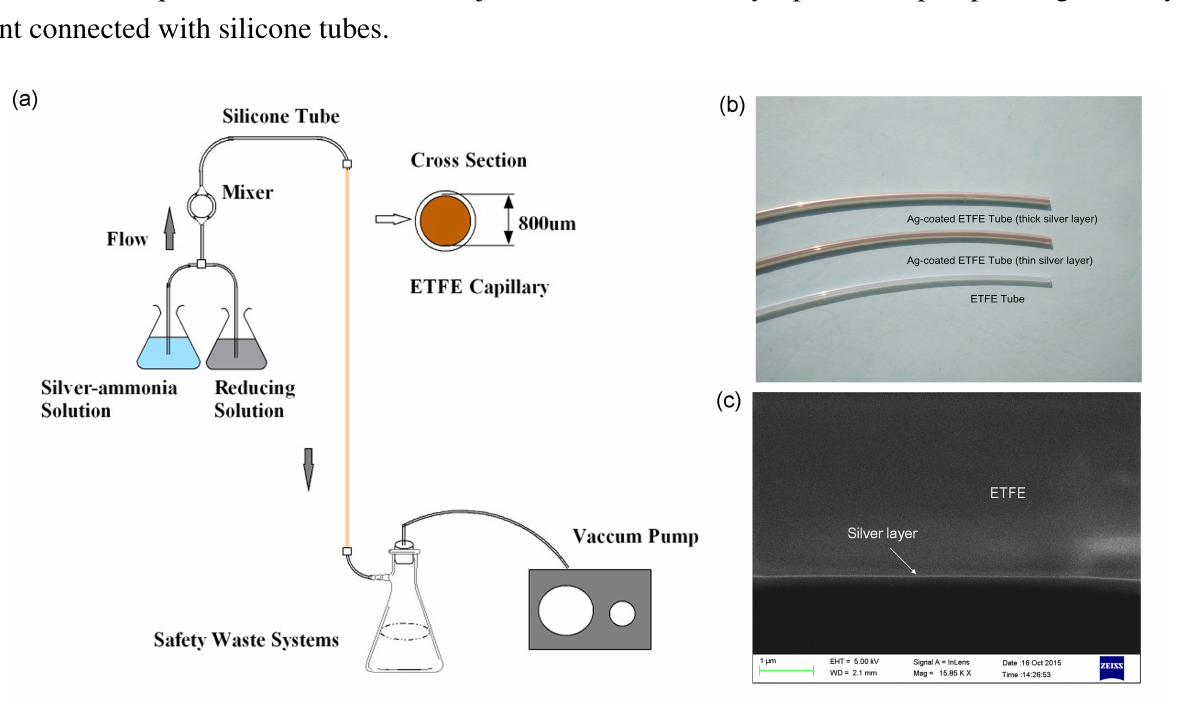
Figure 2. ( a ) Schematic diagram of the liquid phase coating method for silver plating; ( b ) ETFE tube and two Ag-coated ETFE tubes with different Ag film thicknesses; ( c ) SEM picture of the cross-section of the HF used in the experiment.